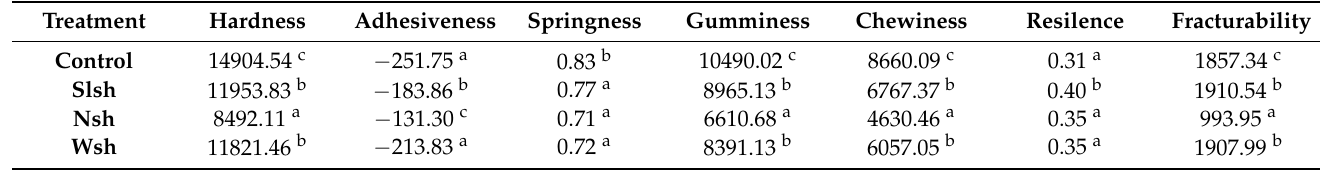
Table 2. Texture profile analysis at the optimal cooking time for each kind of pasta assayed.